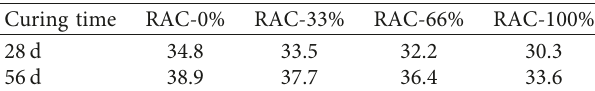
Figure 3: Capillary water absorption of RAC without imposed damage. (a) Capillary absorption curves of RAC with various RCA re- placement percentages. (b) Correlation between capillary water absorption and RCA replacement percentages. Table 3: Compressive strength of RAC after various curing